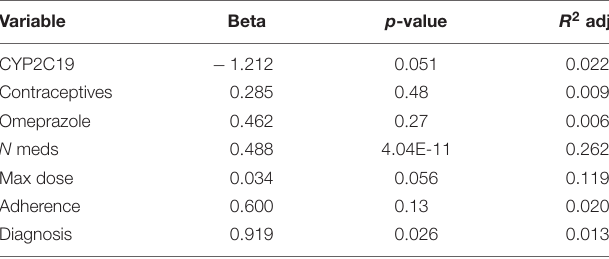
TABLE 5 | Multivariate model of total number of side